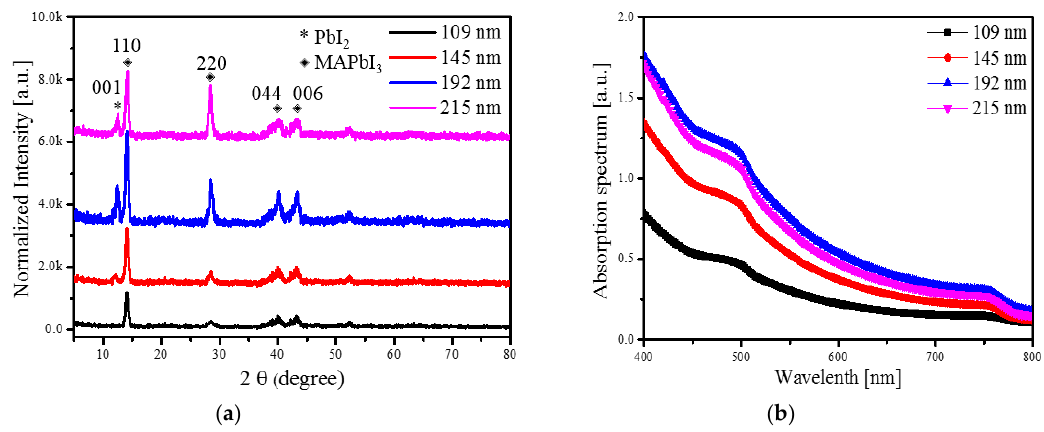
Figure 7. ( a ) XRD patterns and ( b ) absorption spectra of MAPbI 3 layer with di ff erent thicknesses at an annealing temperature 100 °C.